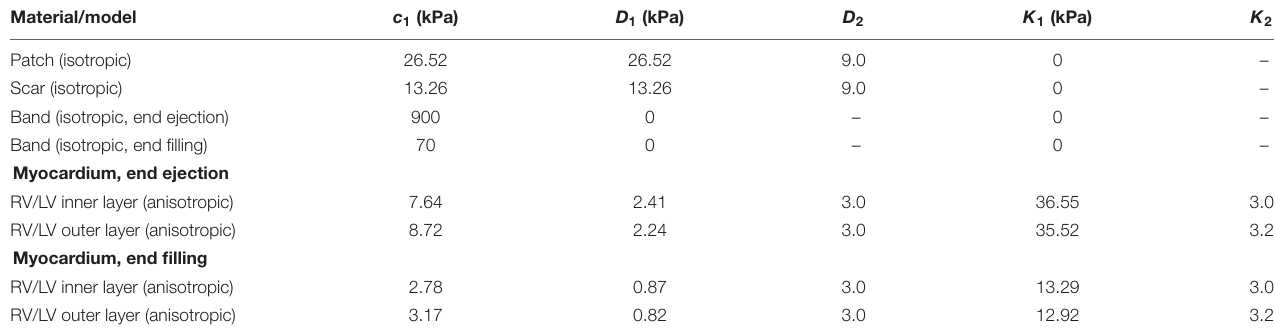
TABLE 3 | Summary of parameter values of the Mooney–Rivlin models for patient 5 patch, scar, RV tissue, and band ( c 2 = 0 kPa).